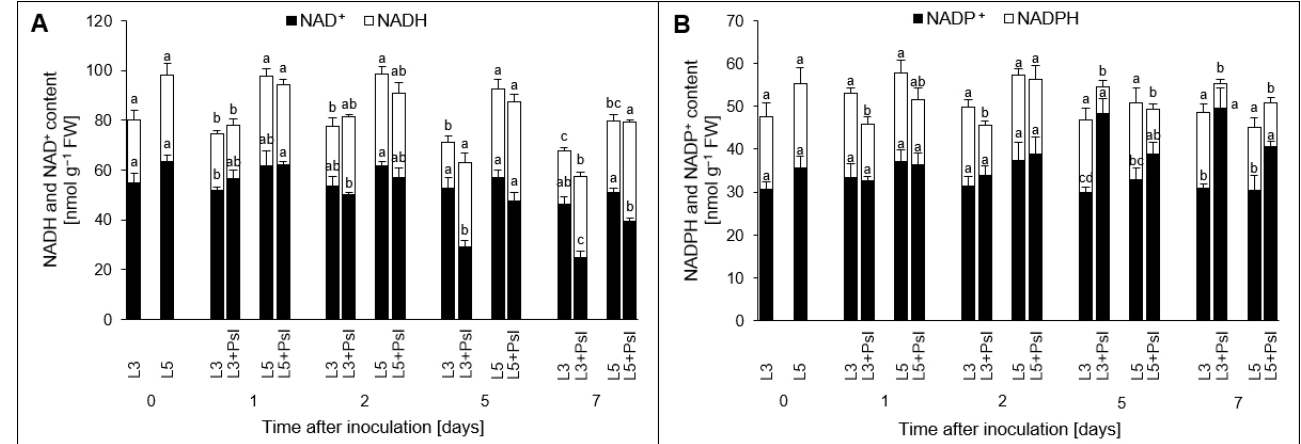
Figure 1. Nicotinamide adenine dinucleotide contents in cucumber leaves after P. syringae pv lachrymans infection: ( A ) NADH, NAD + and ( B ) NADPH, NADP + . Values are means of four replicates (±SD). Different letters (a–d) indicate significant ( p ≤ 0.05) differences between experimental variants within a given time